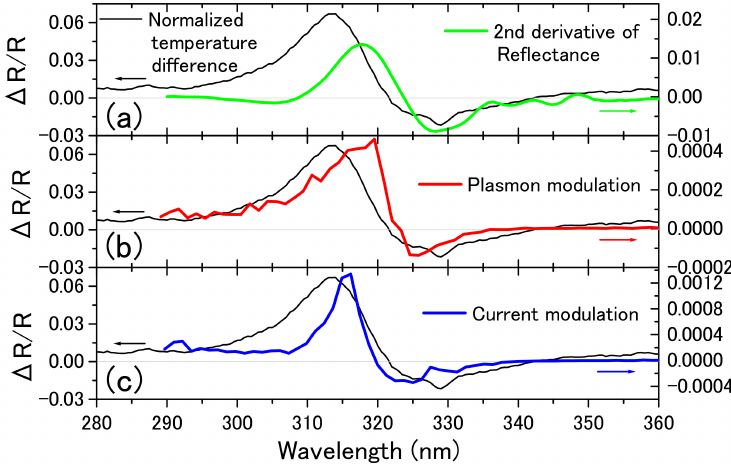
Figure 8. Comparison between plasmon modulation (red, ( b )), current modulation (at 1.56 A, blue, ( c )), temperature difference spectra (at ∆ T = +50 K, thin black line), and the second derivative of the reflectance (green, ( a )) calculated from the reflectance in Figure